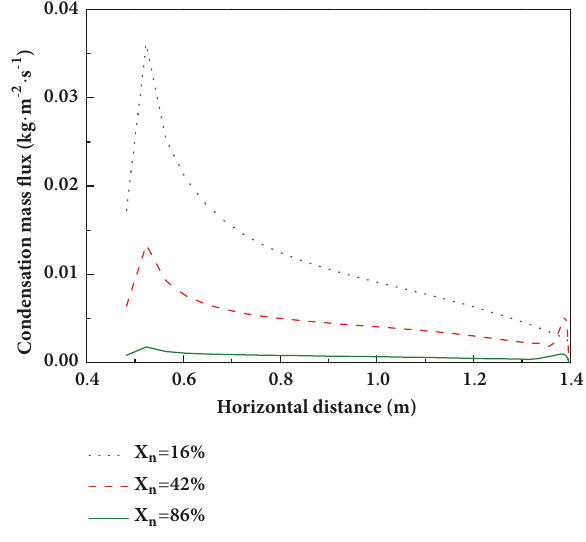
Figure 9: The distribution of condensation mass flux along the top